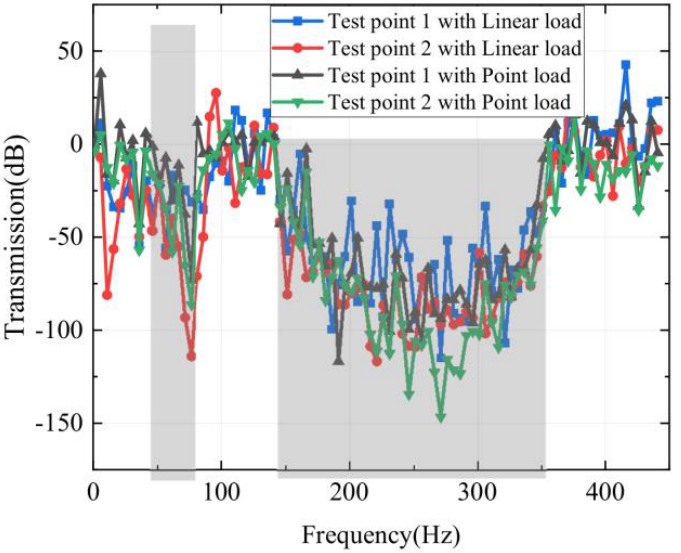
Figure 14. Flexural vibration frequency responses of real ship-scale phononic crystal sandwich plate structure.